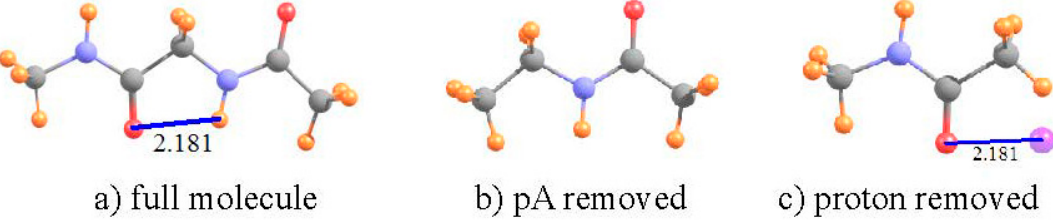
Figure 3. ( a ) Structure of C5 geometry of CH 3 NHCOCH 2 NHCOCH 3 dipeptide. The left hand CH 3 NHCO group has been replaced by a methyl group in ( b ); and the right hand NHCOCH 3 peptide replaced by H in ( c ). Purple sphere in ( c ) indicates position of H-bonding NH proton from ( a ). All distances in Å.